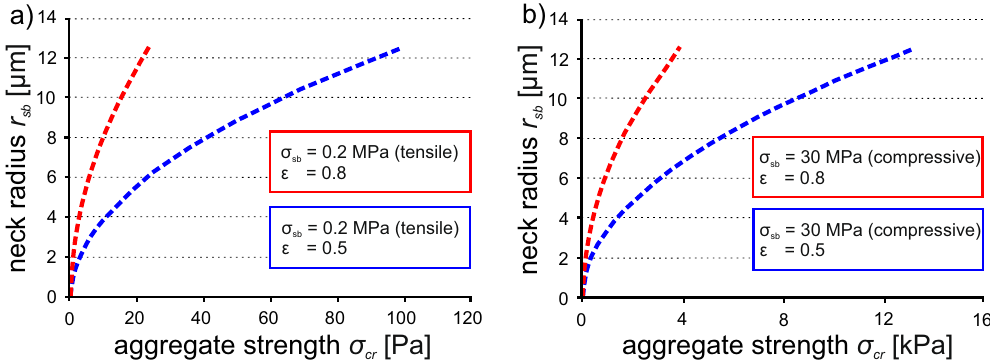
Figure 7. Aggregate strength σ cr of artificial aggregates have been computed, following the models of Johnson et al . 49 and Rumpf 48 . Solid salt bridge neck radii represent SEM analysis results or our artificial aggregates. ( a ) shows aggregate strengths for tensile stress case and aggregate porosities ε of 0.5 and 0.8. ( b ) shows aggregate strengths for compressive stress case and aggregate porosity of 0.5 and